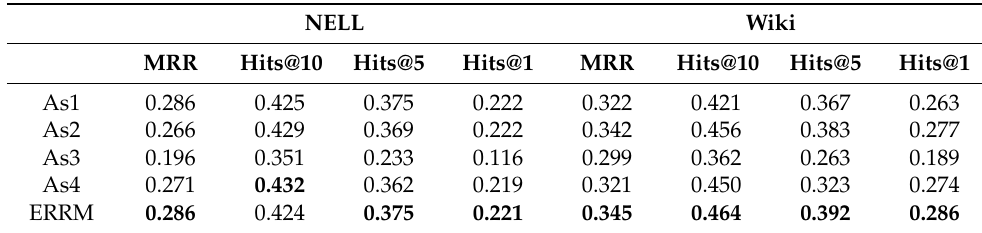
Table 4. Ablation study (best values in